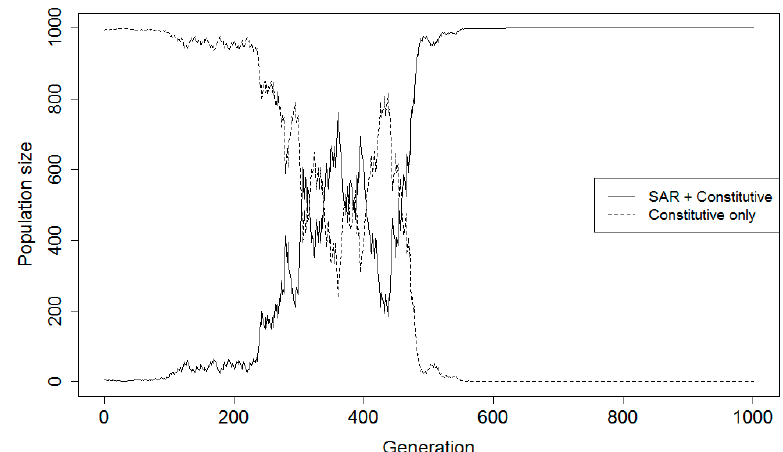
Figure 2. Example projections for one run of a game theory model simulating hypothetical plant populations with (SAR + Constitutive) or without (Constitutive only) the capability for systemic acquired resistance (complementary resistance strategies) over 1,000 generations when disease certainty was 40%, the probability for a priming false positive was 40% and the probability for a false negative was 20%.